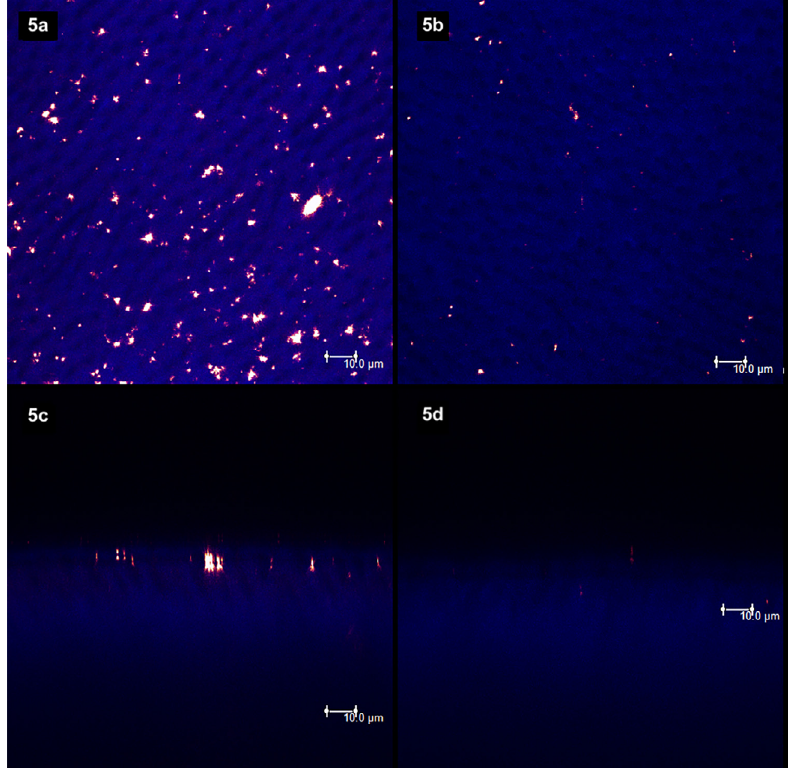
Figure 5- The toothpaste with 5 wt.% of S-PRG was able to promote the formation of some solid deposits on the dentin surface (5a) and at the aperture of dentinal tubules (5c). After the erosive challenge, however, these deposits were almost completely removed from the surface (5b) and from the dentinal tubules